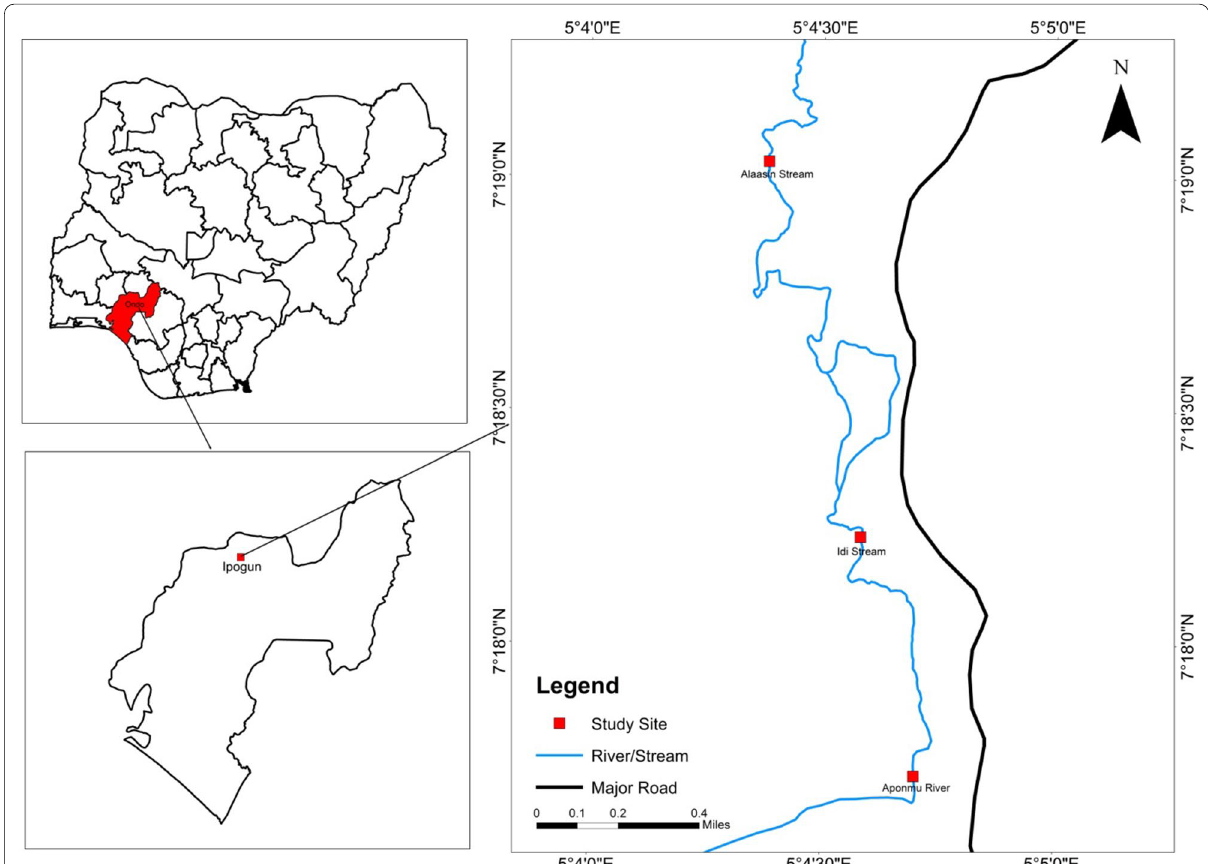
Fig. 1 Map of study area showing the study sites in Ipogun, Ifedore Local Government, Ondo